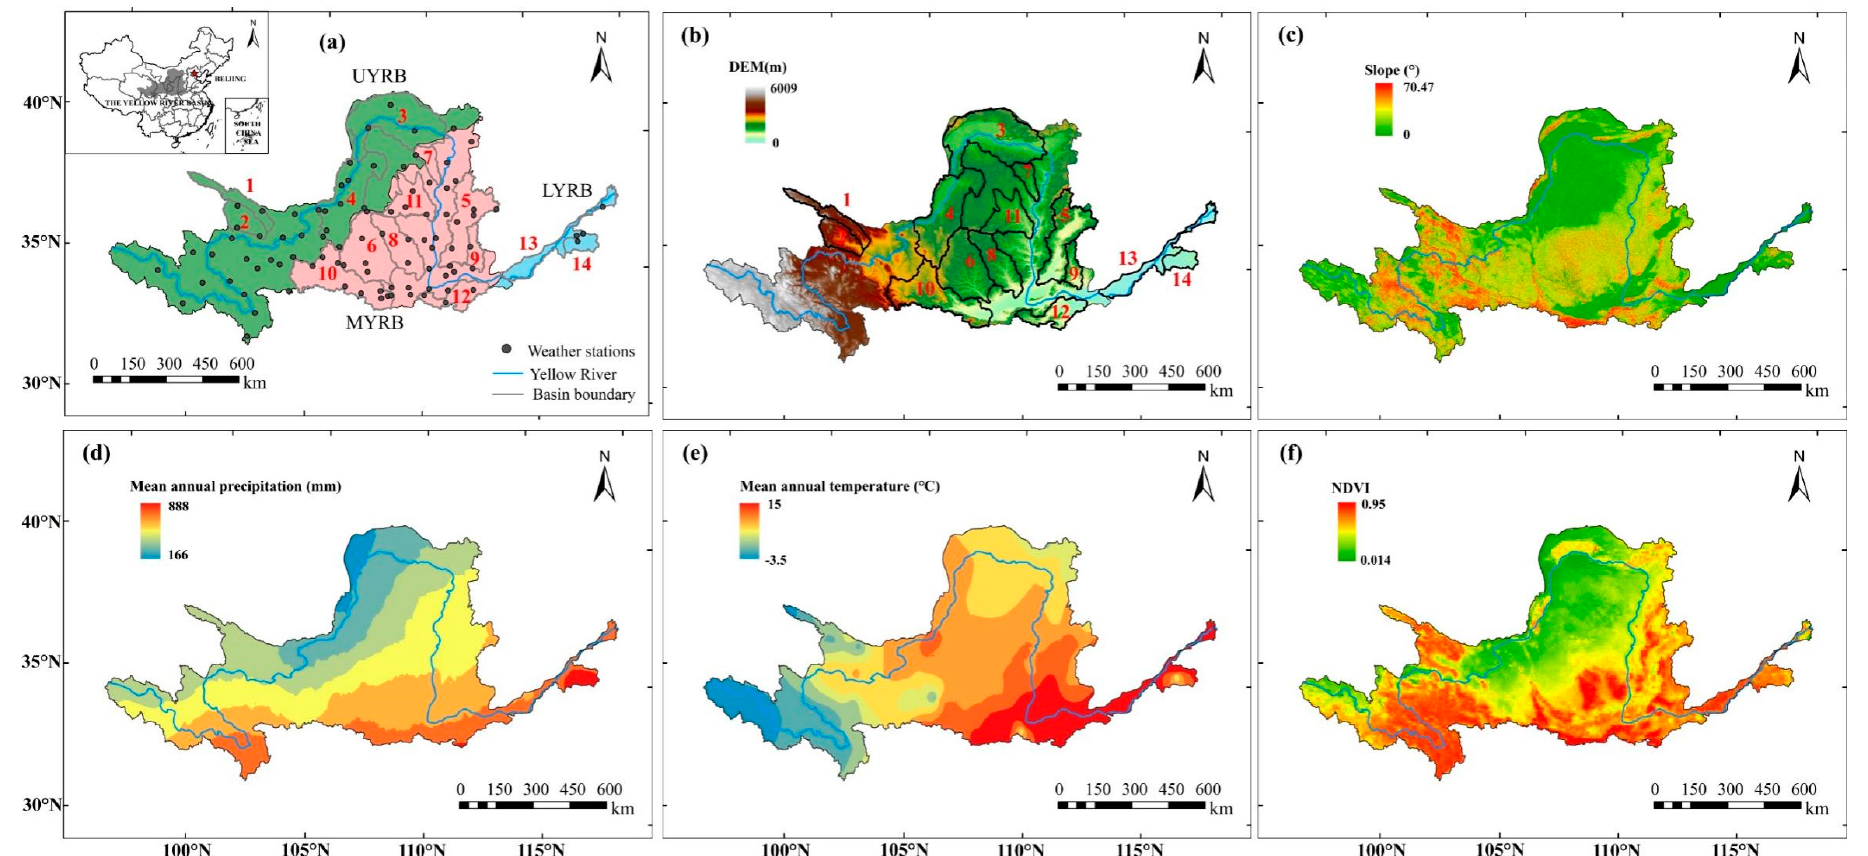
Figure 1. Topography of the Yellow River Basin and the spatial pattern of basic elements. ( a ) Geographical location, among which the UYRB, the MYRB, and the LYRB represent Upper Yellow River Basin, Middle Yellow River Basin, and Lower Yellow River Basin, respectively. Red numbers represent selected sub-basins.